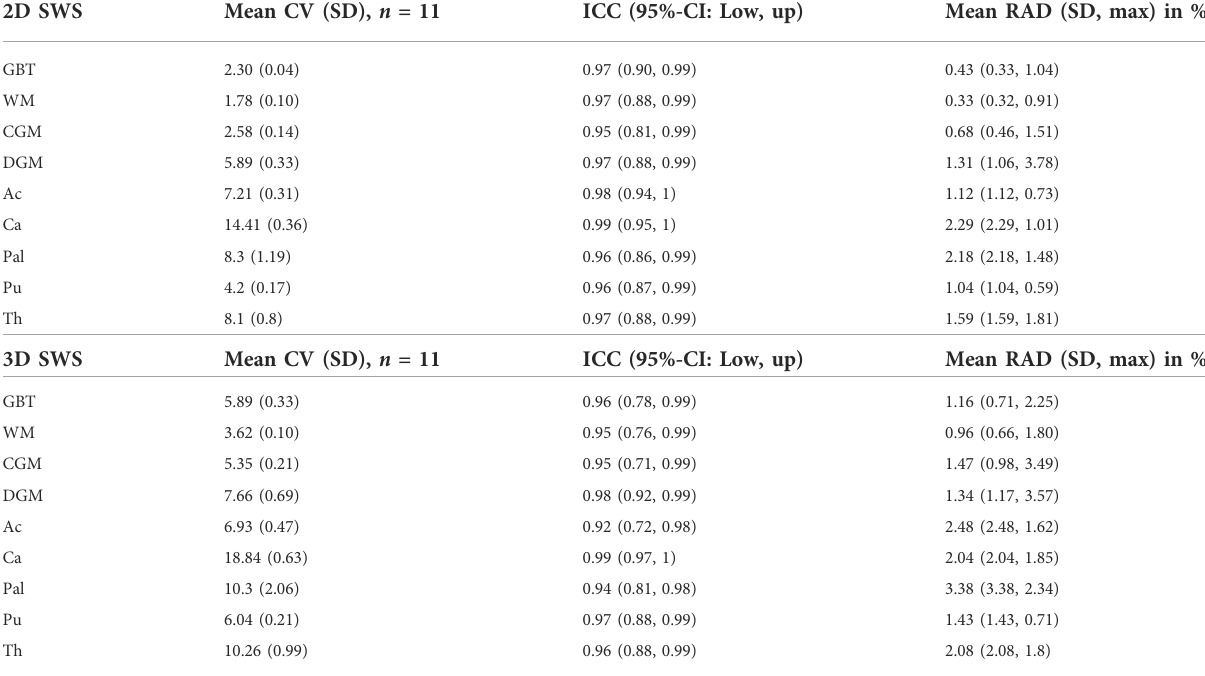
TABLE 2 Coef fi cient of variation (CV) and intraclass correlation coef fi cient (ICC) for 2D and 3D SWS reconstructions for global brain tissue (GBT), white matter (WM), cortical gray matter (CGM), deep gray matter (DGM) and DGM subregions. CV is given as an average of three CVs for baseline, 1-day, and 1-yearmeasurement in eleven volunteers ( n = 11). ICC and mean relative absolutedifference (RAD) were determined from baseline and 1- day repeat measurement.